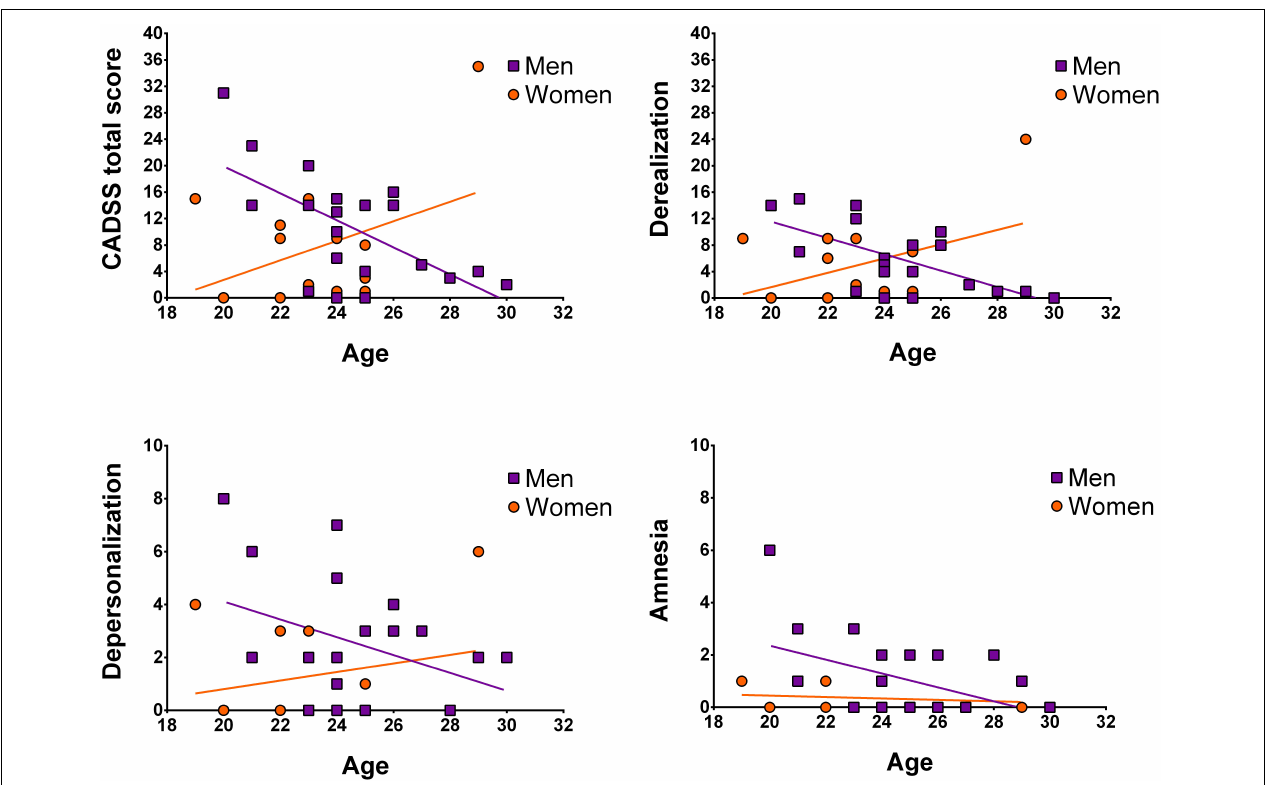
FIGURE 2 | Illustration of correlations between age and CADSS scores separately for women and men. Data points are not corrected for weight.